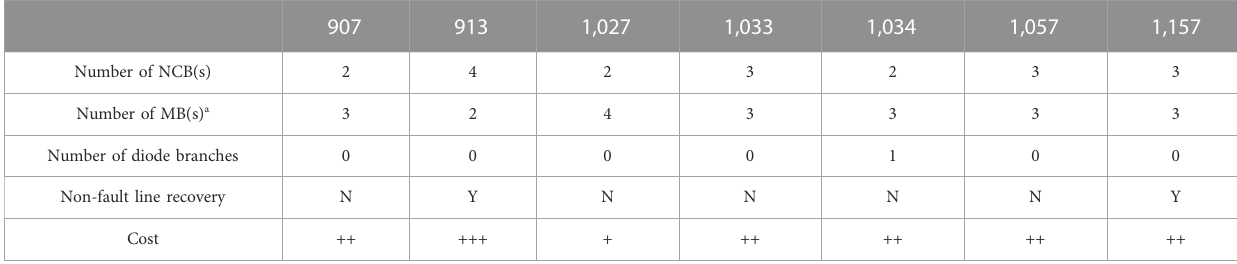
TABLE 5 Comparison in the one common connection point situation.